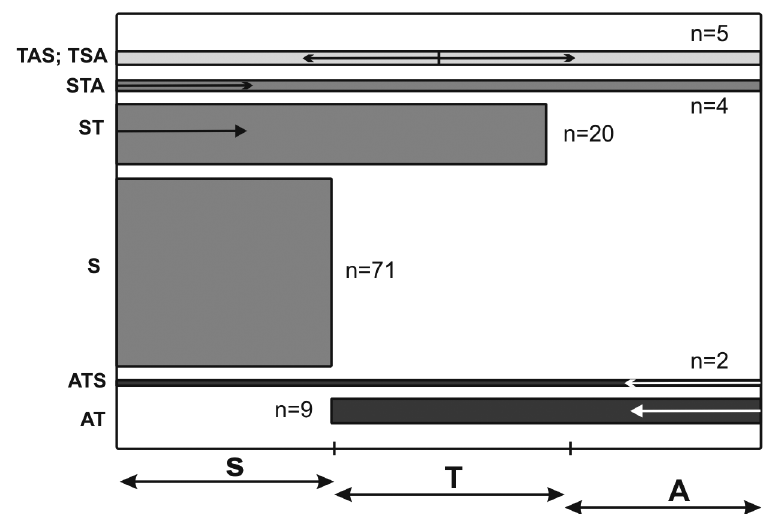
Figure 6 - Distribution of 111 tree species in the Brazilian Pantanal according to their preference along the moisture gradient. S = terrestrial habitats normally not subjected to inundation; T = habitats inundated during short periods (<two months), A = habitats inundated during long periods (> two months). Arrows indicate the supposed direction of expansion of the species from the center of maximum density (according to Nunes da Cunha and Junk